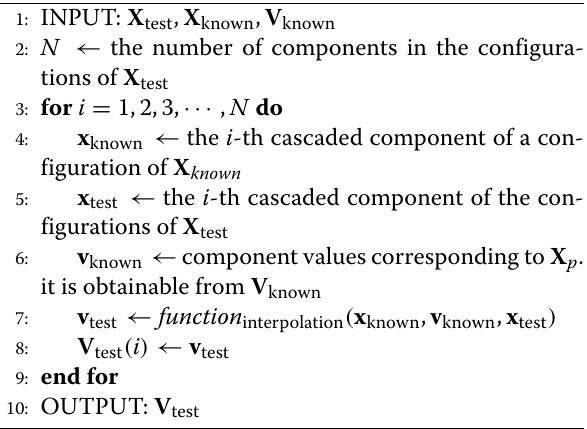
Algorithm 2 The Interpolation Approach: